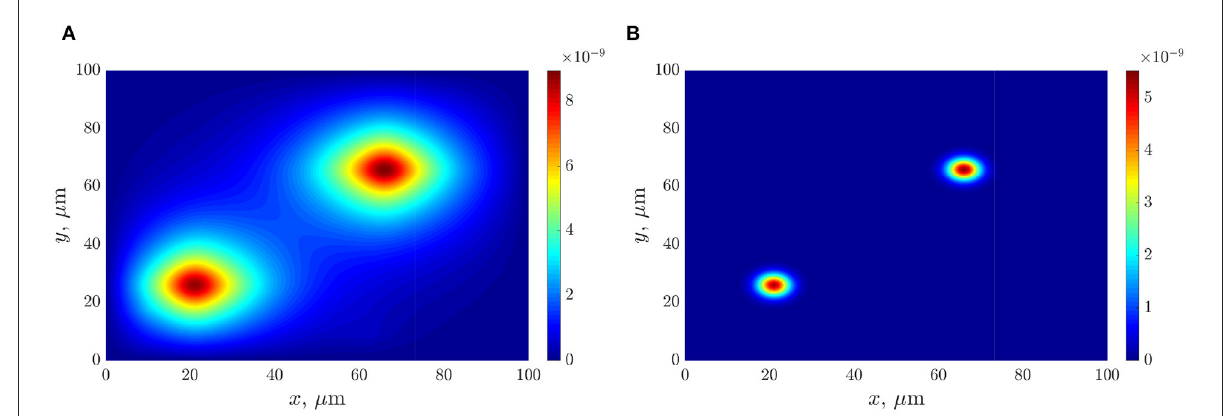
FIGURE6 The distributions of chemical compounds calculated at time 12 h: (A) —the AHL concentration; (B) —the Lactonase concentration.